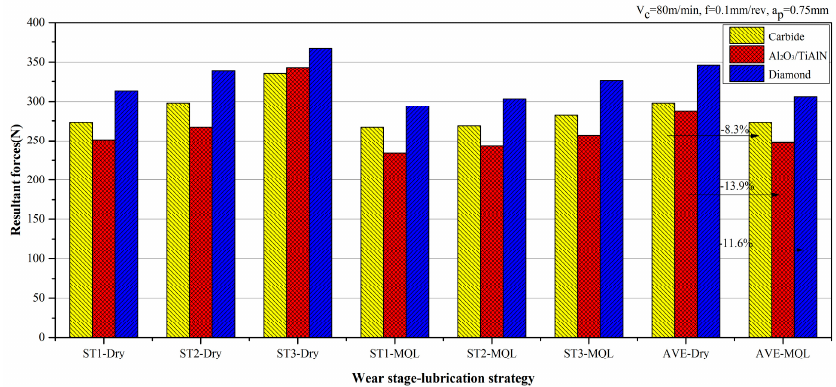
Figure 4. Cutting force comparison under dry and MQL conditions.